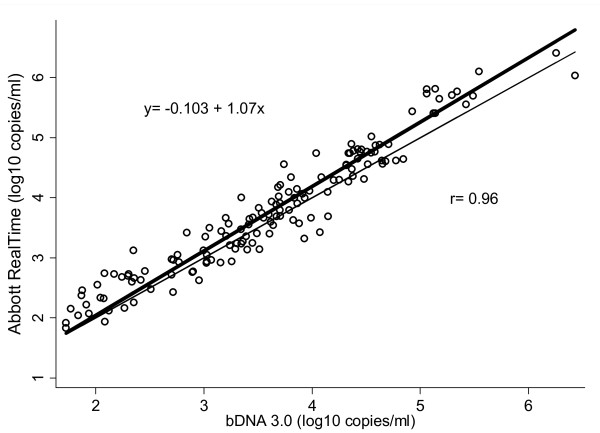
Correlation between the bDNA 3.0 and the Abbott RealTime assays. The bold line represents the regression line. The equation of the fitted line and the Pearson's correlation coefficient are presented on the plot. Values are expressed as log10 HIV-1 RNA copies/ml.